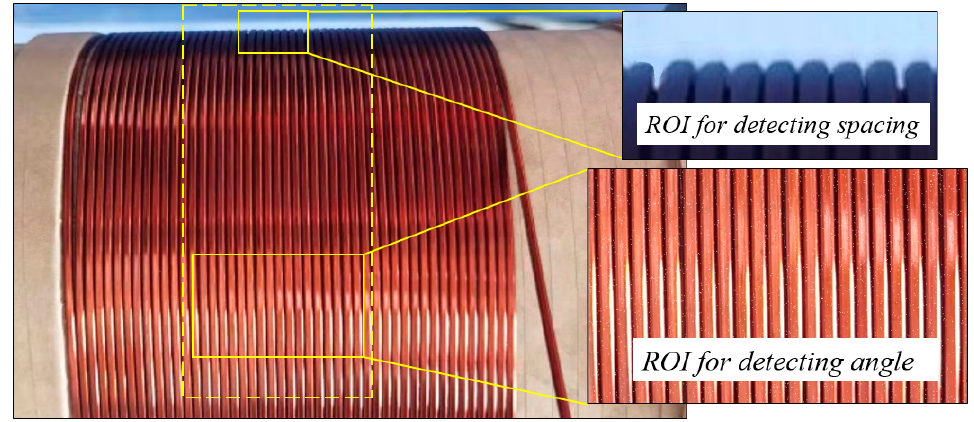
Figure 6. Select ROI region.